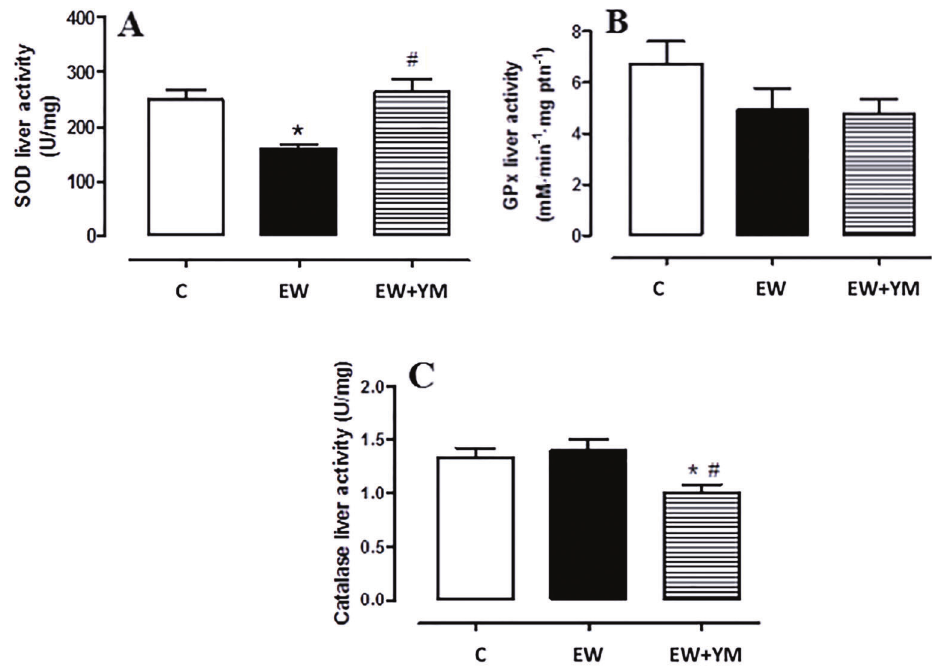
Figure 2. Early weaning decreased superoxide dismutase (SOD) activity, and yerba mate treatment reduced catalase activity in the liver. A , SOD, B , glutathione peroxidase (GPx), and C , catalase activities in the liver at postnatal day 180 of adult rats that were normally breastfed for 21 days (C), early weaned (EW), or EW that received yerba mate for 30 days (EW + YM). Data are reported as means ± SE of 10 rats per group. *P o 0.05 vs C; # P o 0.05 vs EW (ANOVA and Newman-Keuls multiple comparison